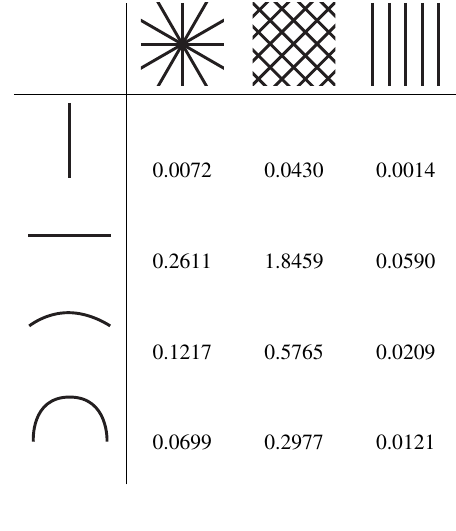
Table 1. The linearized stiffness measure κ at the endpoint in de undeformed state is given for the four shape variants and the three material orientation variants. A low value indicates a low out-of- plane stiffness as compared to the in-plane